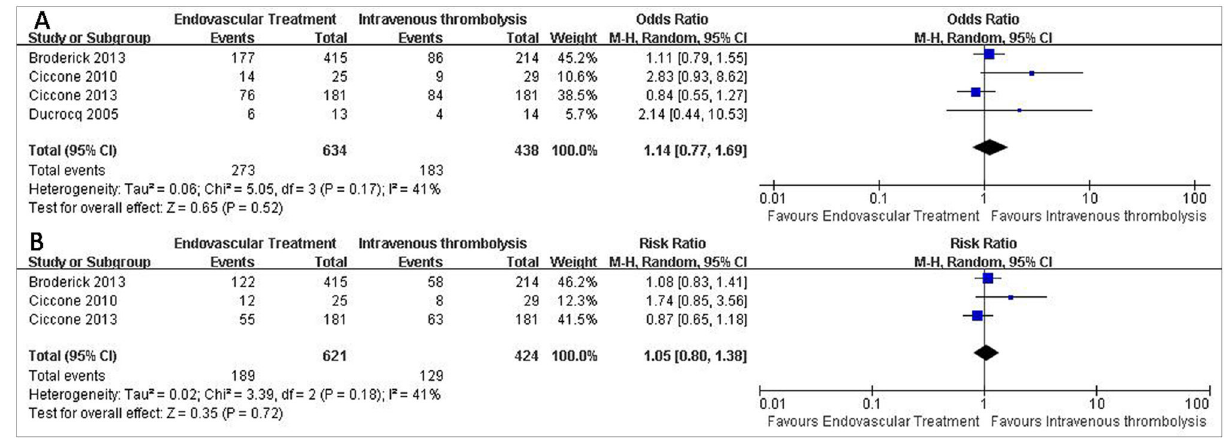
Figure 2. Primary Outcomes of patients treated with Endovascular Therapy and Intravenous Thrombolysis after acute ischemic stroke. (A) Forest plot of RR and 95% CI for the occurrence of good outcome in patients assigned to Endovascular Therapy and Intravenous Thrombolysis. (B) Forest plot of RR and 95% CI for the occurrence of excellent outcome in patients assigned to Endovascular Therapy and Intravenous Thrombolysis. doi: